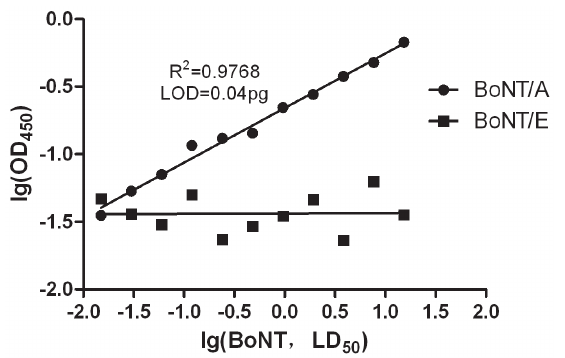
Figure 5. Detection and quantitation of BoNT/A and BoNT/E using IgY